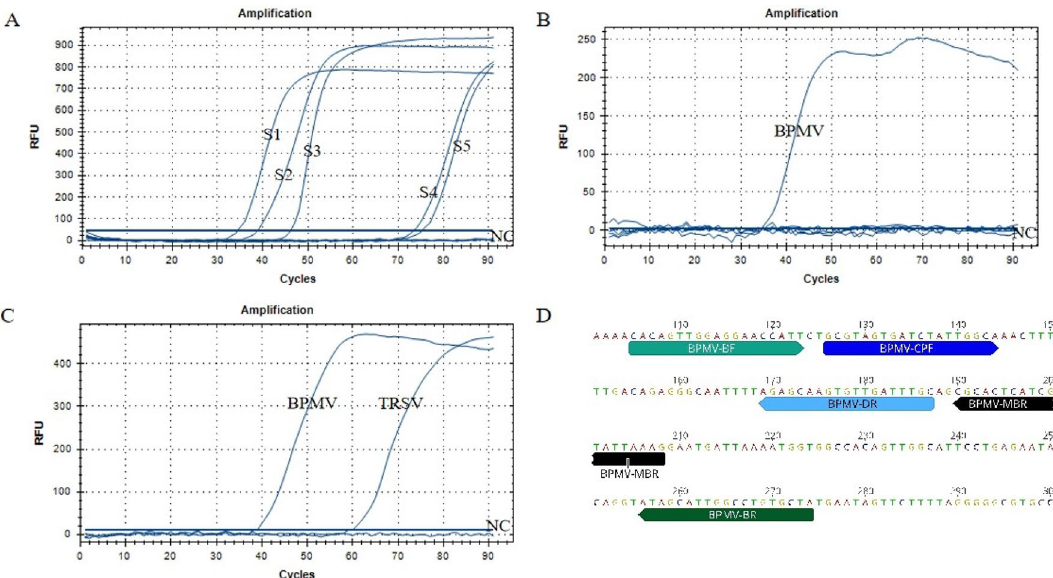
Figure 1. Primer set screening by real-time fluorescent RT-CPA for BPMV detection. ( A ) Reaction curves of the five sets of primers S1–S5. ( B – C ) Specific tests for primer sets S1 and S2 on five common plant quarantine viruses infesting soybean seeds: SBMV, ToRSV, ArMV, TRSV, and BPMV. ( D ) Primer location of primer set S1 on the BPMV coat protein. Arrows show directions. One cycle represents 1 min in real-time fluorescent RT-CPA. NC, negative control with RNase-free distilled water.